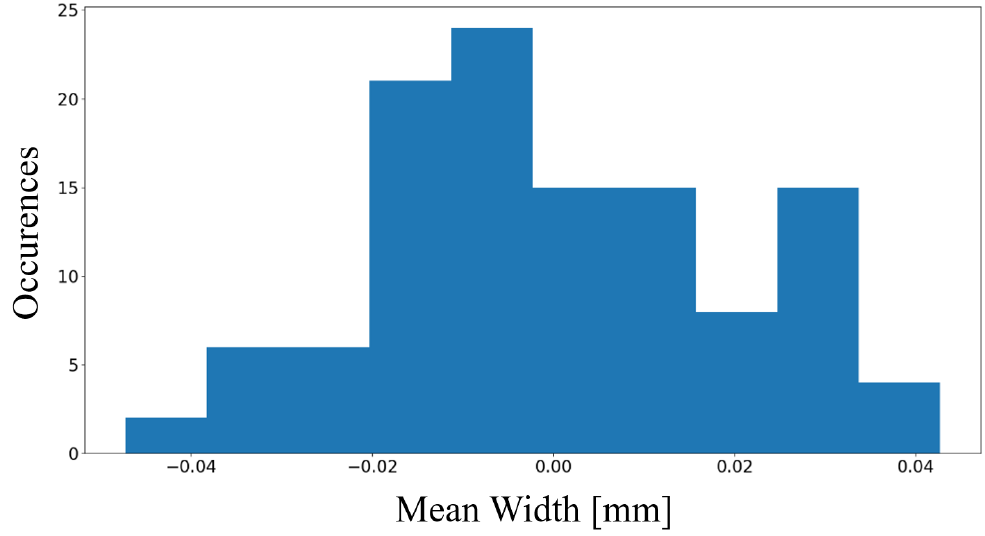
Figure 33. Distribution normalized with respect to the average value of mean width values measured on 100 images by the same